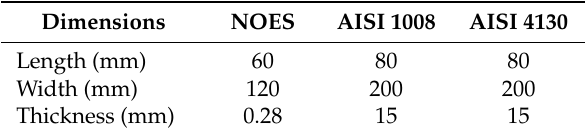
Table 2. Dimensions of ferromagnetic steel samples before